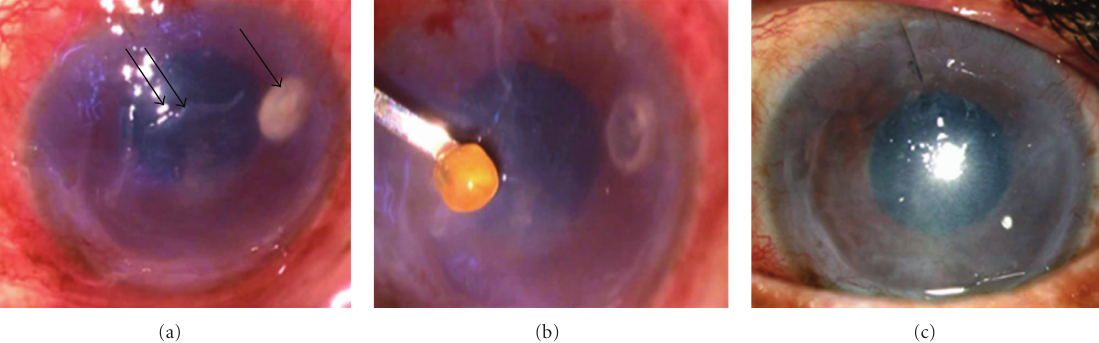
Figure 1: (a) Clinical picture showing infiltrate (arrow) in the corneal stroma with epithelial defect (double arrow) in the surrounding area as seen under microscope. (b) Picture shows yellowish crystalline lens removed from within the infiltrate. (c) Slit lamp picture after one month of surgery showing scarred cornea with a mid-dilated pupil. Note total clearing of the infiltrates.